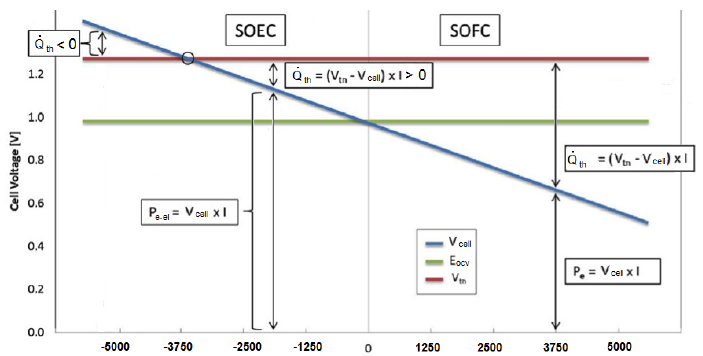
Figure 2. Typical SOFC–SOEC polarization curve. In this picture, the electrical and thermal power in fuel cell and electrolysis mode are shown. Adapted from